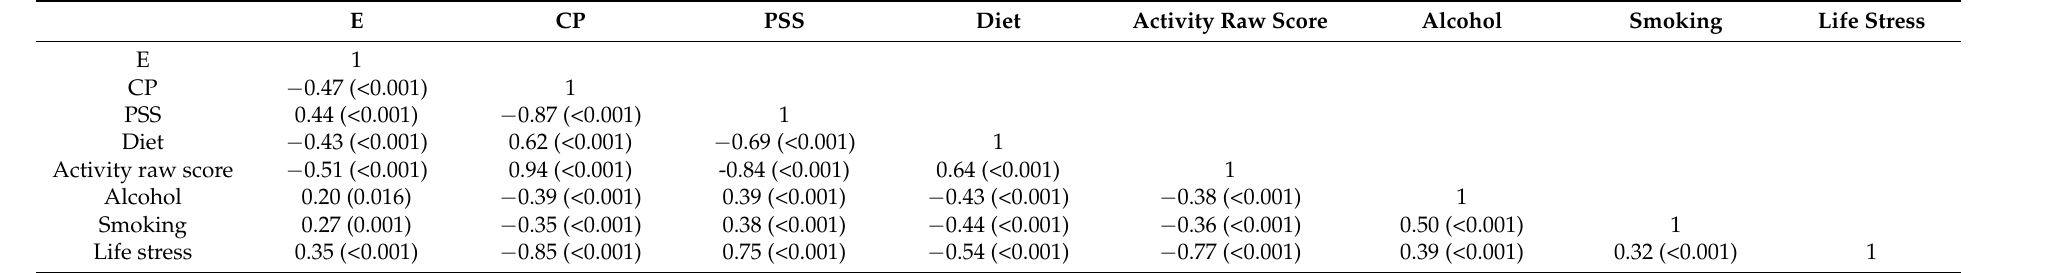
Table 2. Correlations between stress, cognitive performance, and lifestyle among participants before the confinement.